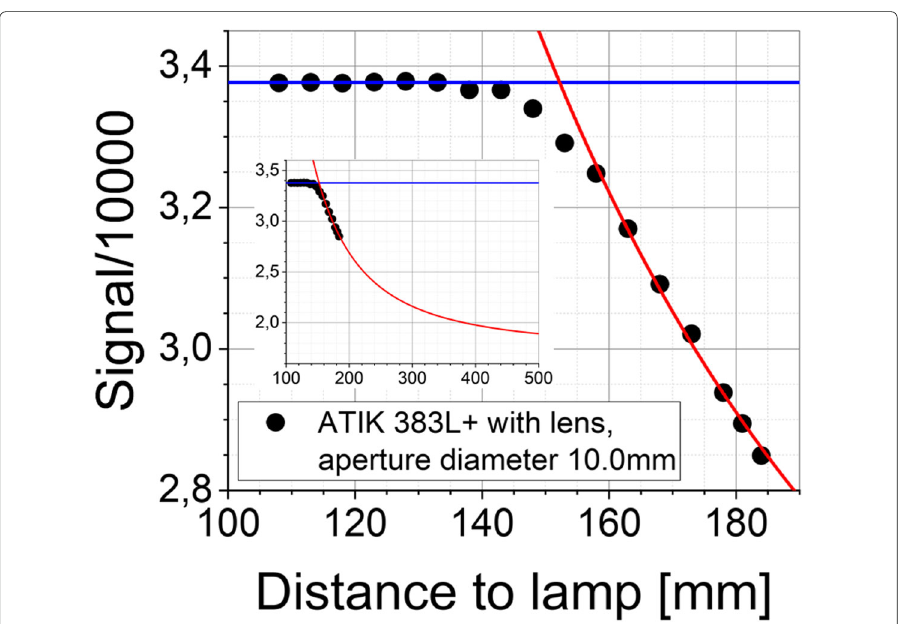
Fig. 3 The light intensity recorded by the camera (Signal) is shown versus the distance of the aperture ( X , in Fig. 1) to the tungsten-strip. The concept of the measurement is described in the text. The constant intensity value for distances shorter than 143mm corresponds to a solid angle of 3.84 · 10 − 3 sr. In red the I ( x ) = I 0 · x 2 0 / x 2 + U fit function is plotted. The blue line is the constant level of intensity before the point of reduction. The smaller plot inside the main plot shows a wider distance and signal range in the way it is expected to